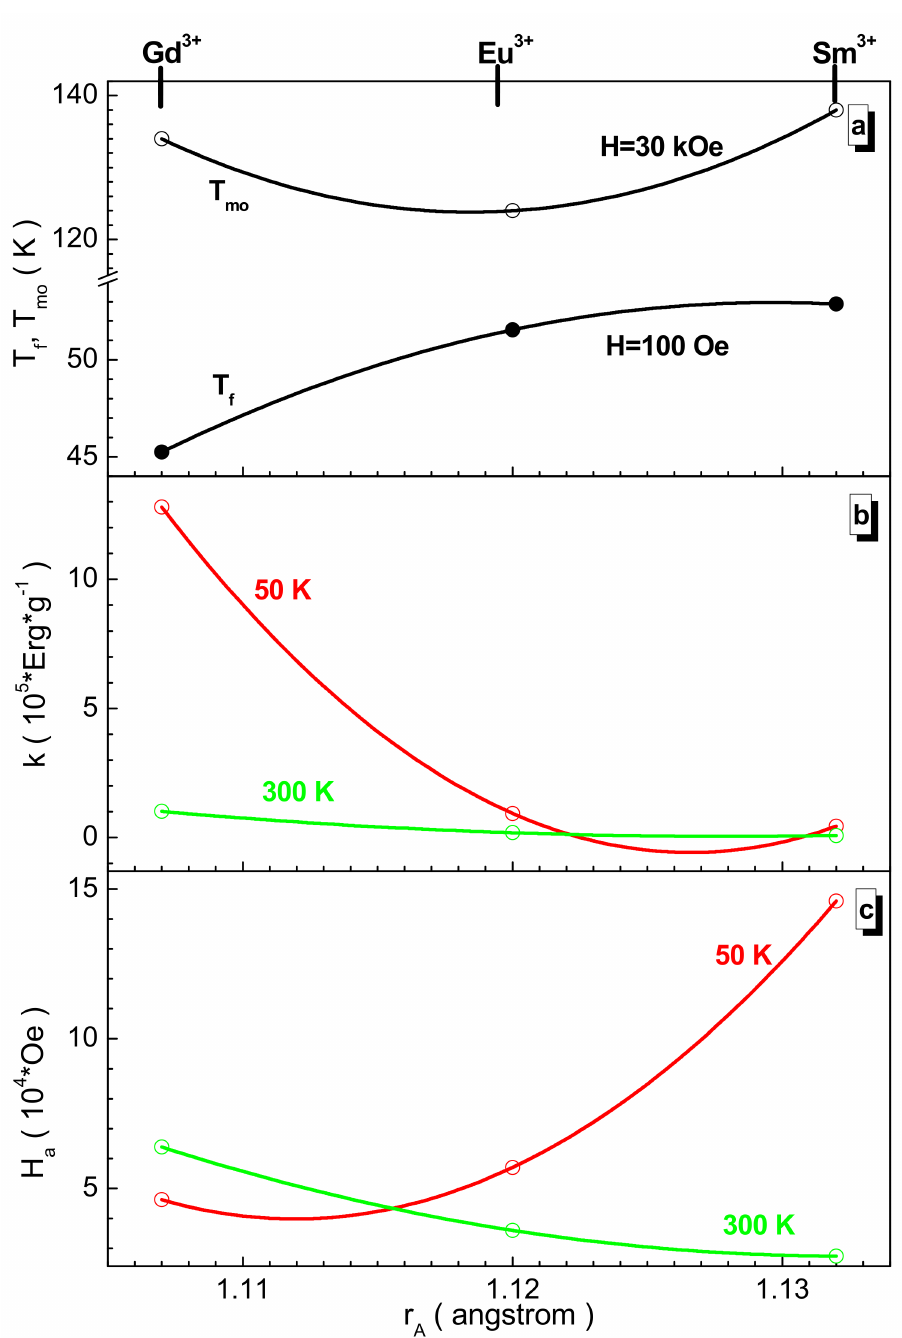
Figure 9. Dependence of the T mo magnetic ordering (in 30 kOe) and T f freezing (in 100 Oe) tempera- ture ( a ), k magnetic crystallographic anisotropy coefficient ( b ), and H a anisotropy field ( c ) vs. A-site cation radius size at 50 K (red circle and line) and 300 K (green circle and line) for the obtained samples. The solid line is the second-order polynomial interpolation and it is an eye